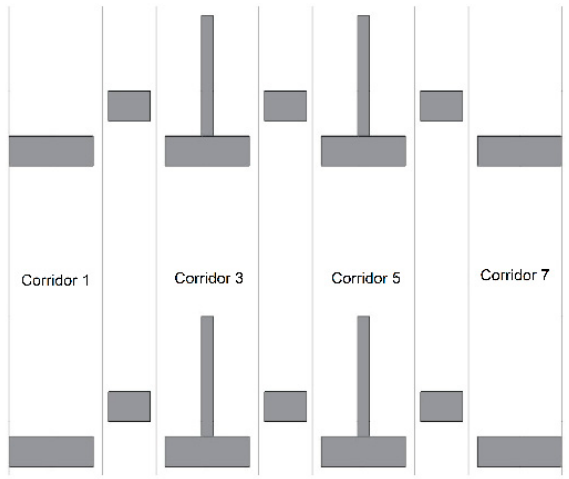
Figure 5. Details of friction walls position of double rectangular boulder with a small barrier layout (DRb3).